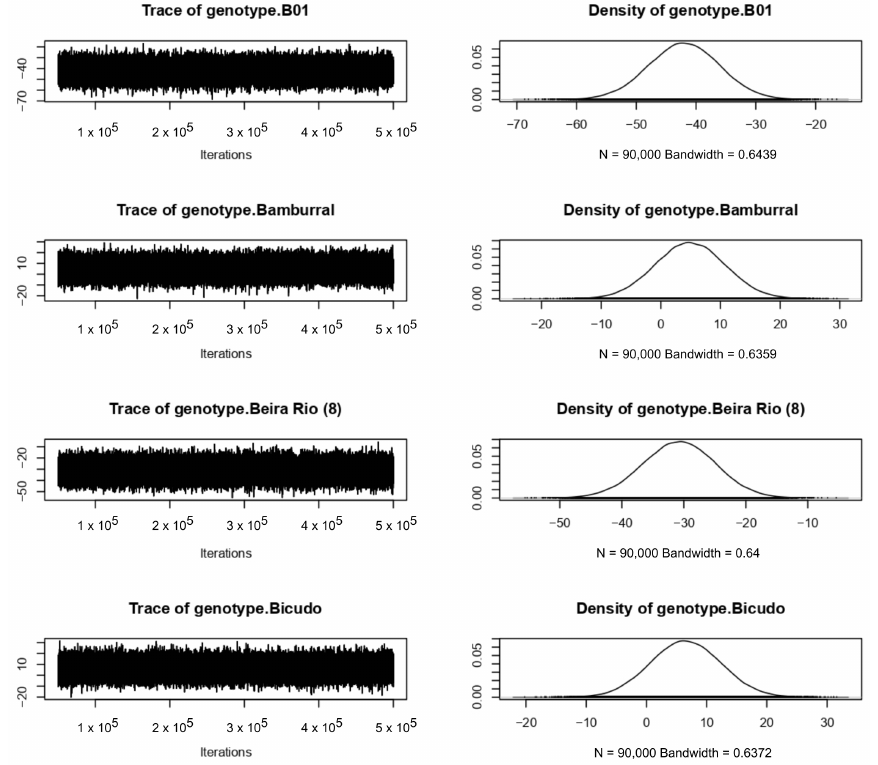
Figure A3. Time series of the chains and density curves of the effect of genotypes B01, Bamburral, Beira Rio (8), and Bicudo.